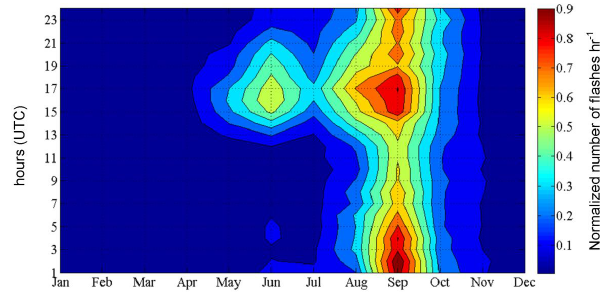
Figure 2: Hour-month diagram of the hourly CGF totals recorded within the Iberian 791 Fig. 2. Hour–month diagram of the hourly CGF totals recorded within the Iberian sector (IS: 36–44 ◦ N, 10 ◦ W–5 ◦ E) and averaged Sector (IS: 36-44ºN; 10ºW-5ºE) and averaged over the 7-year baseline period (2003- 792 over the 7yr baseline period (2003–2009). Values are normalized to 2009). Values are normalized to unit maximum. 793 unit